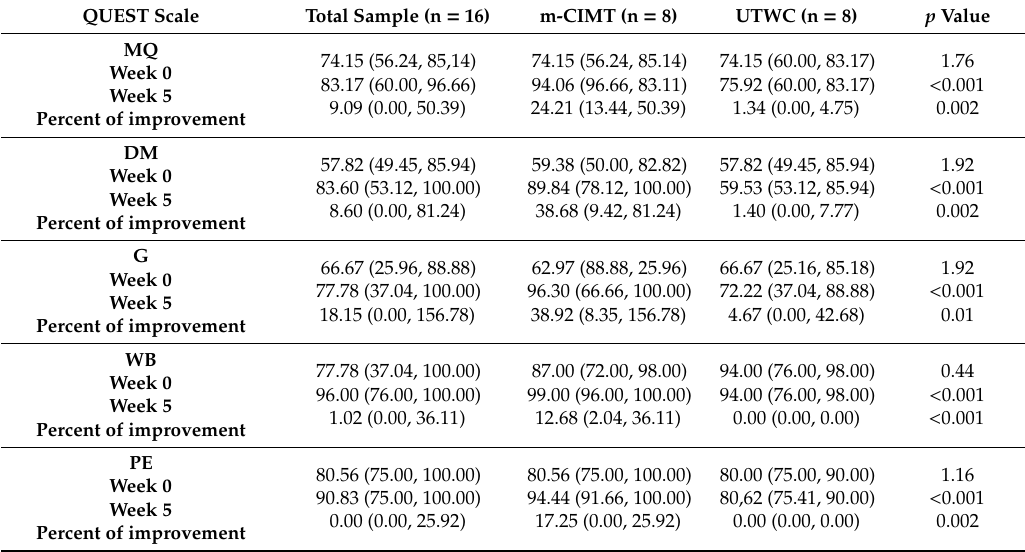
Table 3. Results and percent of improvement per group and total sample in the variables measured with the Quality of Upper Extremity Skills Test (QUEST)